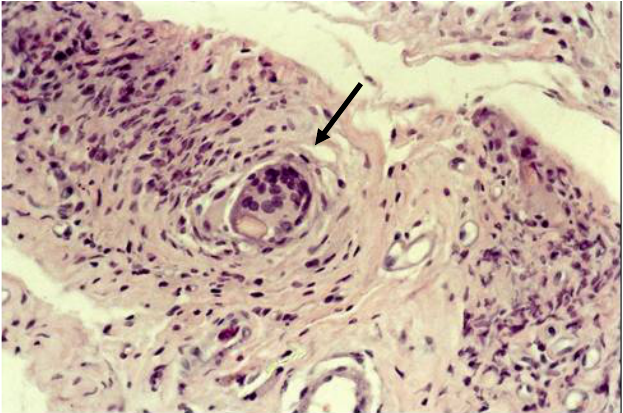
FIGURE 5 – Giant cell reaction to foreign body at serosa. Multi- nuclear cell with a fagocyted foreign body. Hematoxilin and Eosin color. 40 X Zoom/close-up